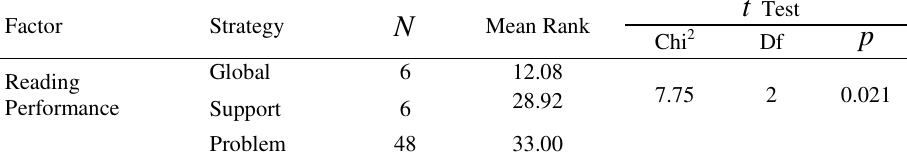
Table 2 Kruskal Wallis H Test for Reading Performance & Reading Strategy Types